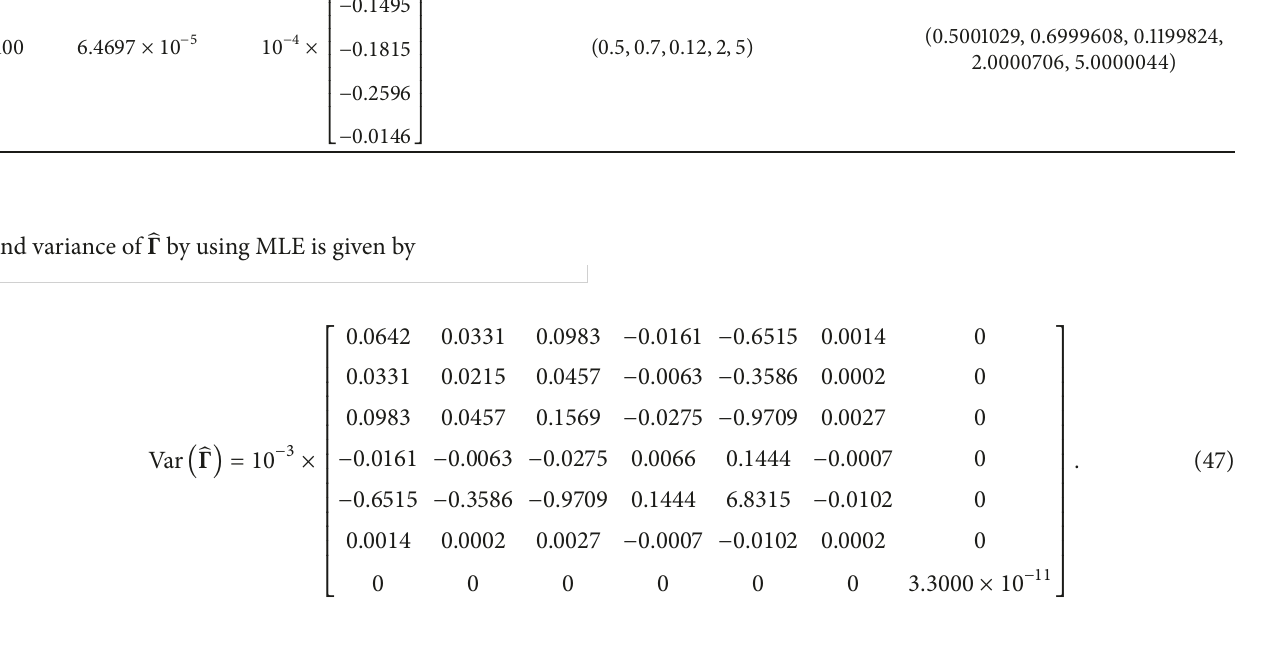
Table 8: Table showing value of Max.Val (𝑙) , ∇𝑙( Γ ) , and 𝑀 Max.Val